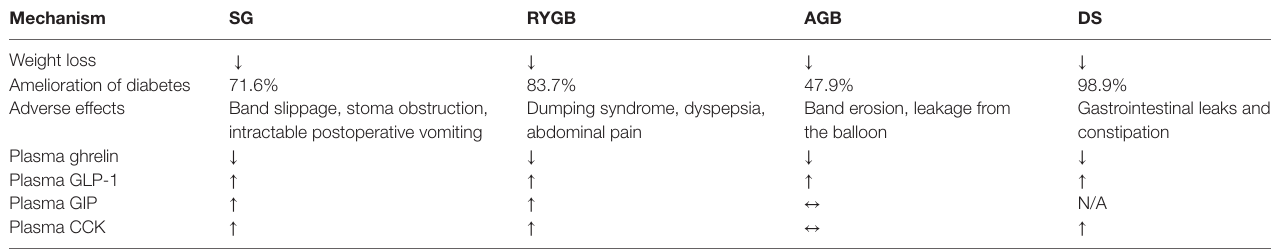
TABle 1 | Efficacy of different bariatric surgeries.